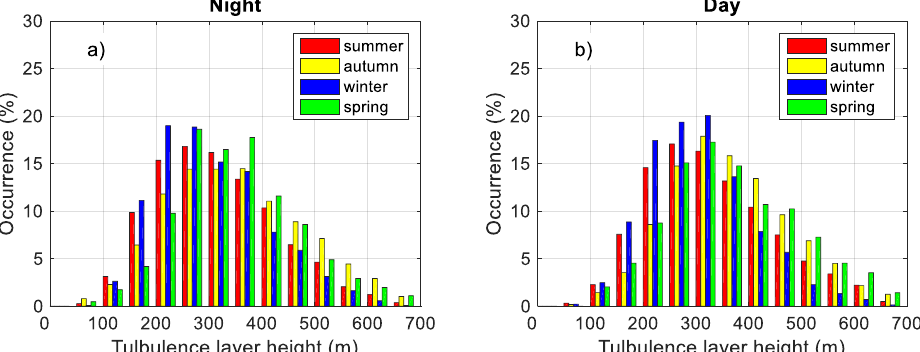
Figure 20. Histograms of the turbulent layer height H different seasons.